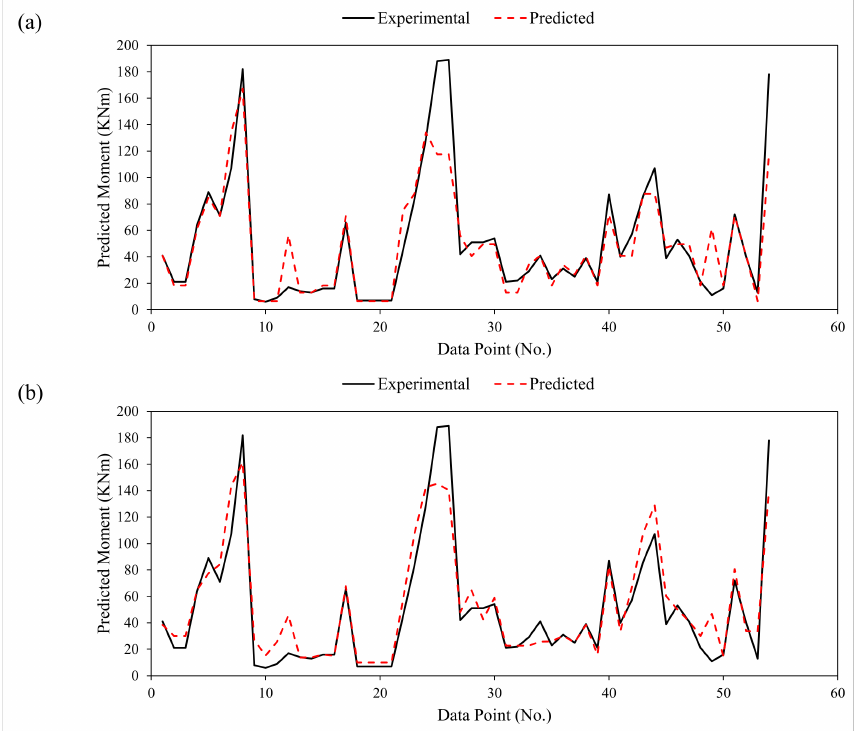
Figure 5. Tracing of experimental values by the predictions in the validation phase of the ( a ) DT, and ( b ) GBT